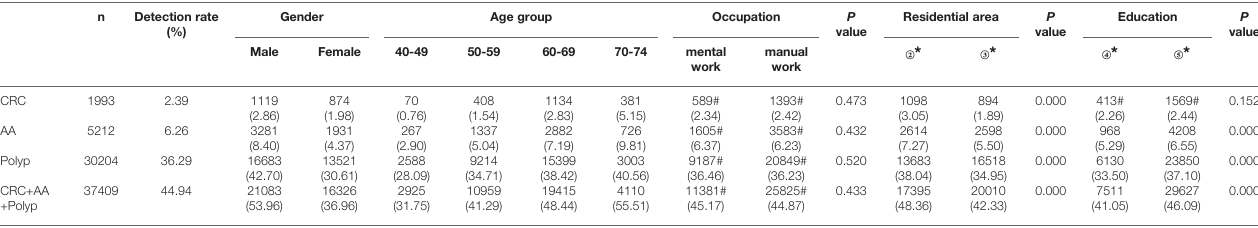
TABLE 10 | Evaluation of the diagnostic performance of colonoscopy, (n,%).